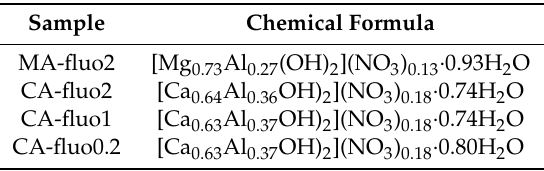
Table 4. Chemical formulae of the synthesized samples. All values rounded to two decimal places.